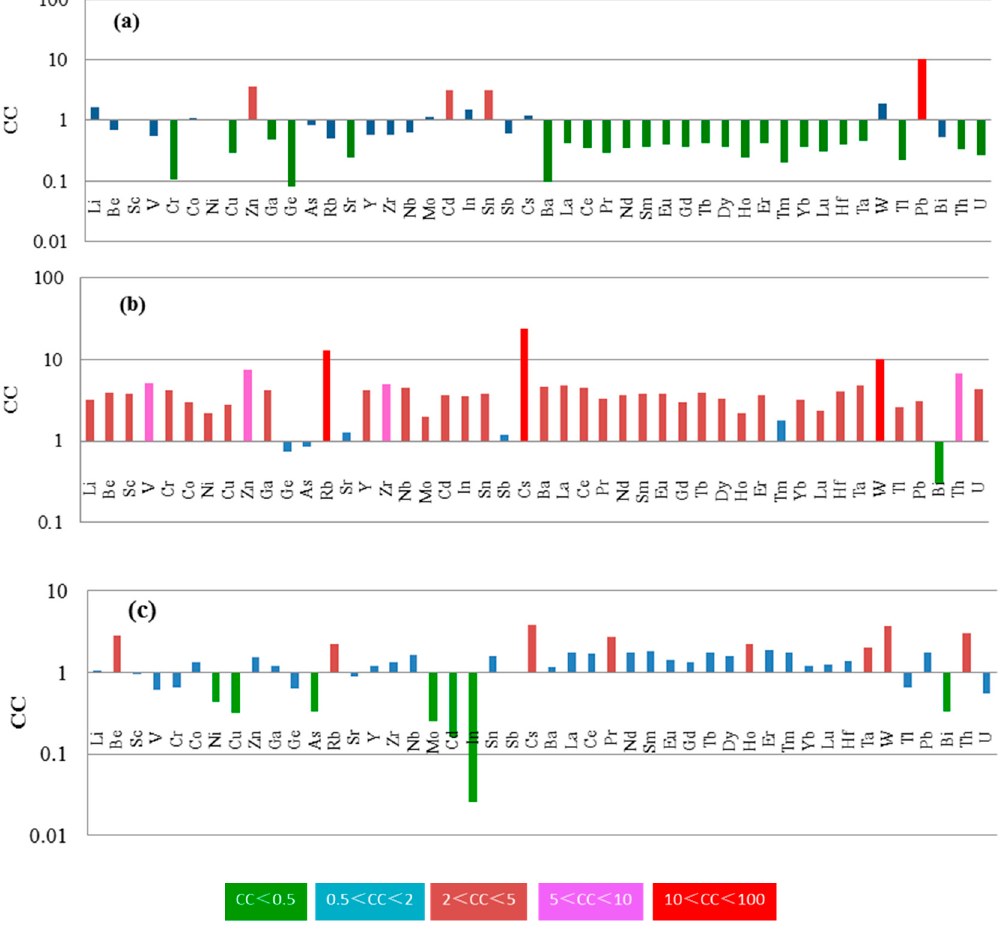
Figure 3. Concentration coefficients (CC) of trace elements in 12U Coal ( a ), 12L Coal ( b ), and host rocks ( c ) from the Meitian Mine, normalized by global average trace element concentrations in hard coals and average mudstones [40].